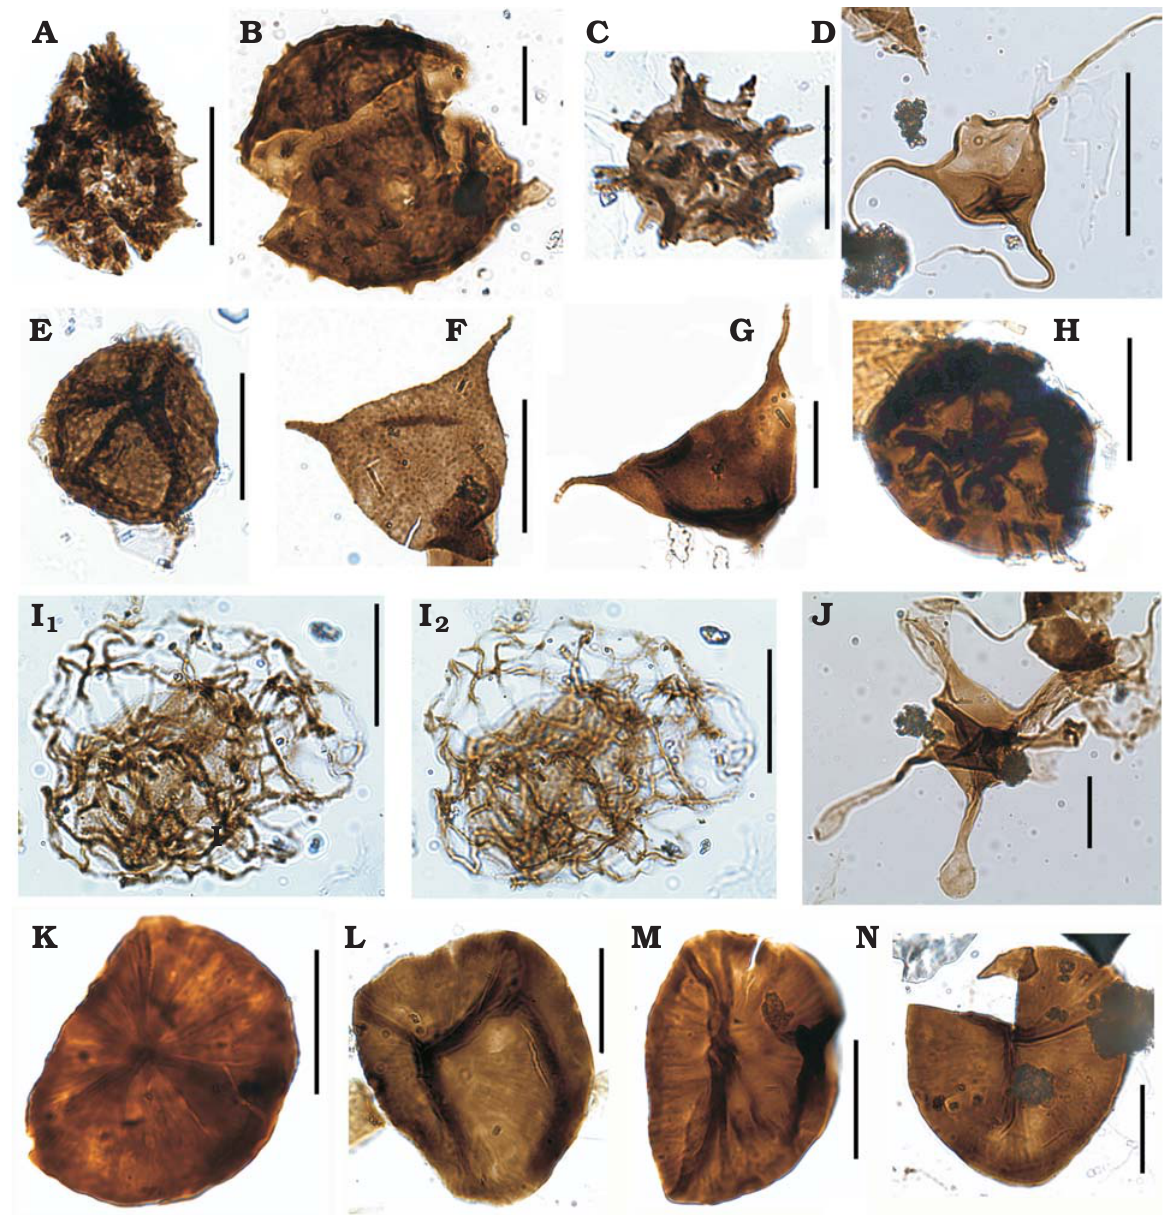
Fig. 11. Palynomorphs from the studied sections of the Los Espejos Formation of Argentina, Quebrada Ancha, P ř ídolí (A, F, K, M, N), Cerro La Chilca, Gorstian?–Ludfordian? (B, L), Quebrada Ancha, Ludfordian (C, E, H), Cerro La Chilca, Ludfordian (D, G, I, J). A . Tylotopalla caelamenicutis Loeblich, 1970; MPLP 14-60982 (E32/3). B . Tylotopalla deerlijkianum (Martin, 1973) Martin, 1978; MPLP 2-61057 (K42/2). C . Tylotopalla robustispinosa (Downie, 1959) Mullins, 2001; MPLP 2-60704 (L42/2). D . Veryhachium trispinosum Group Servais, Vecoli, Li, Molyneux, Raevskaya, and Rubinstein, 2007; MPLP 4-61059 (E33). E . Vestitusdyadus sp.; MPLP 8-60677 (G31/1). F . Villosacapsula setosapellicula (Loeblich, 1970) Loeblich and Tappan, 1976; MPLP 9-60664 (Q30). G . Villosacapsula sp.; MPLP 5-61060 (U32/2). H . Visbysphaera cf. pirifera (Eisenack, 1954) Kiryanov, 1978; MPLP 8-60677 (T33). I . Indeterminate palynomorphs; MPLP 4-61059 (G35/4) (I 1 , I 2 are different focus). J . cf. Veryhachium sp., with abnormal processes, distally expanded; MPLP 4-61059 (P25/3). K – N . Emphanisporites ? tenuis sp. nov. K . MPLP 13-60984 (N30/2). L . MPLP 2-61057 (Q42). M . MPLP 10- 60673 (J23). N . MPLP 12-60986 (R34). Scale bars 20 μ